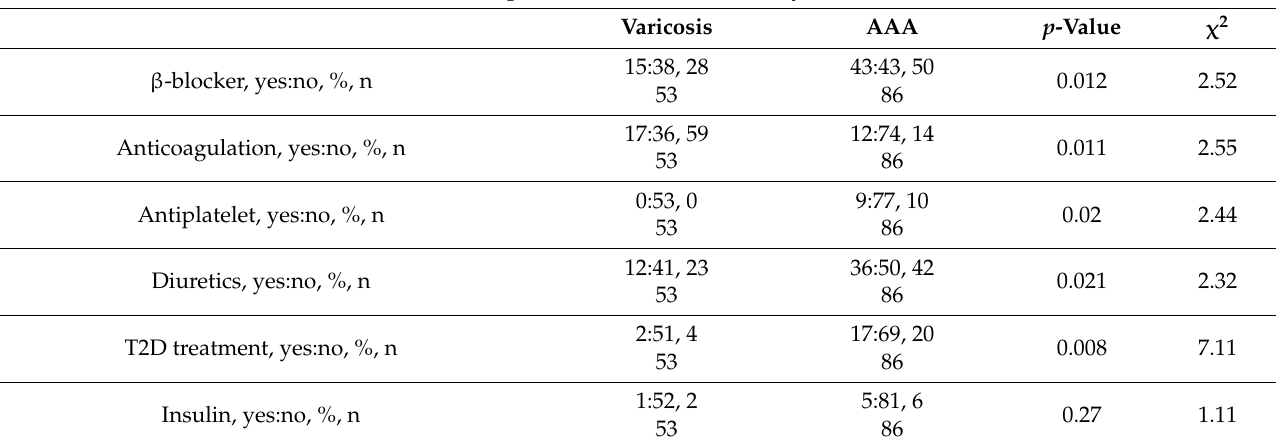
Table 2. Cont. Retrospective, Observational Study